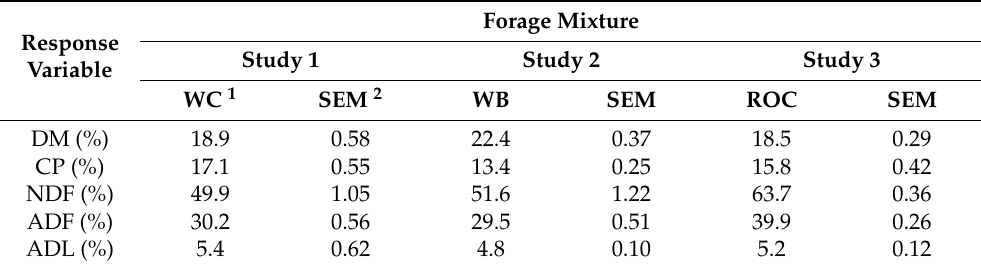
Table 1. Dry matter (DM), crude protein (CP), neutral detergent fiber (NDF), acid detergent fiber (ADF), and lignin concentrations of cool-season annual mixtures ensiled as baleage.